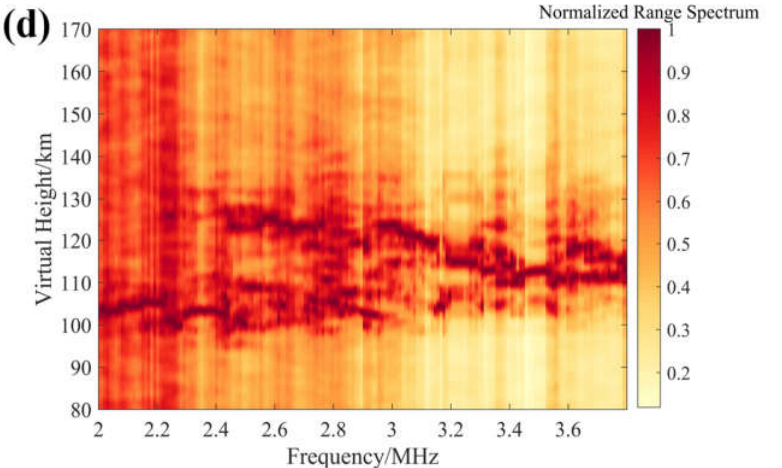
Figure 4. Different types of the Es layer. Ionograms of a c-type Es layer measured near Wuhan, China at ~19:56 LT (UTC+8) on 8 June 2021, with a range resolution of ( a ) 3.84 km and ( b ) 38.4 m. The bottom two panels, ( c ) 3.84 km and ( d ) 38.4 m, show similar results, but for an h-type Es layer measured at 01:12 LT (UTC+8) on 9 June 2021.